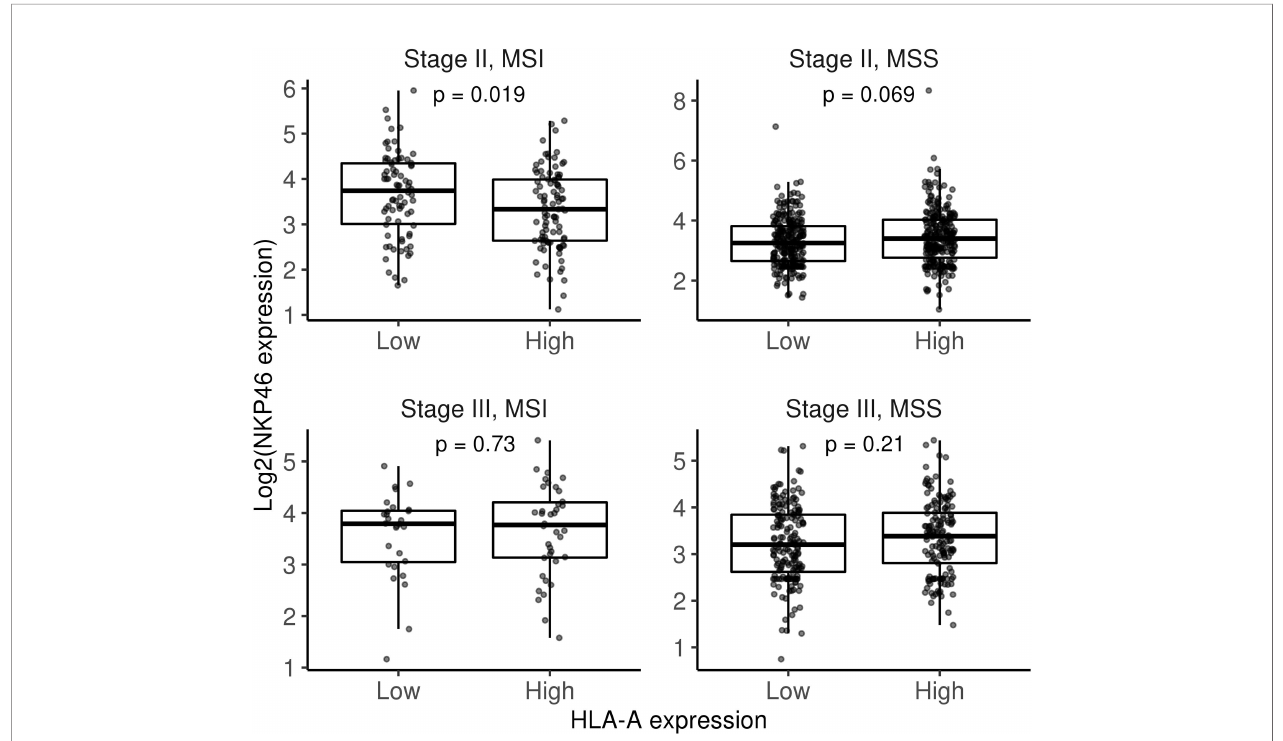
FIGURE 3 | Box plots comparing NKp46 gene expression between low and high HLA-A categories (gene expression median was used as a cutoff) stratifying by stage and MSI/MSS status. Differences were assessed using non-parametric Wilcoxon test. MSI, microsatellite instability; MSS, microsatellite